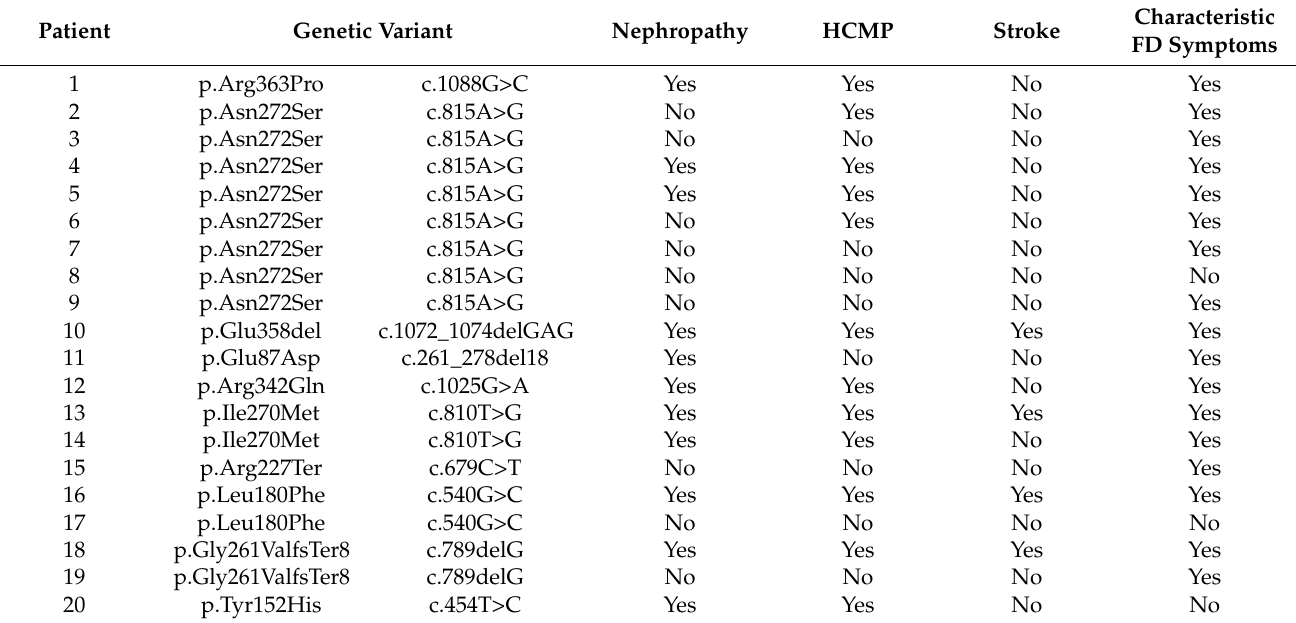
Table 2. Genetic variants in GLA gene (reference sequence NM_000169.2) and phenotypes.